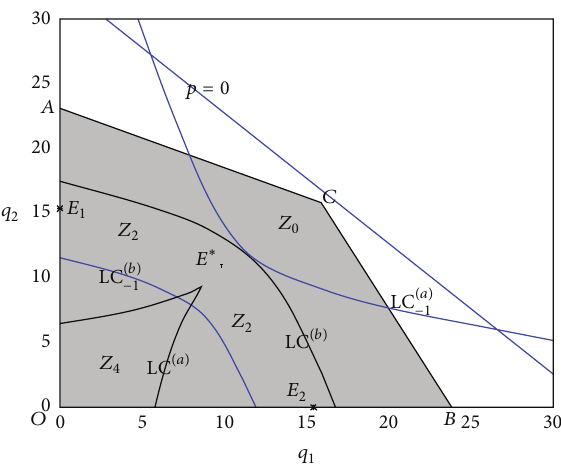
Figure 2: Critical curves are represented for the parameter set: 𝛼 = 0.3 , 𝑎 = 7.2 , 𝑏 = 0.22 , 𝑐 = 0.4 , and 𝛾 = 0.9 . The blue lines LC (𝑎) −1 and LC (𝑏) −1 are the two branches of the LC −1 set. The portion of the plane that lies between the axes and LC (𝑎) defines region 𝑍 4 ; the portion of the plane that lies between the black lines LC (𝑎) and LC (𝑏) defines region 𝑍 2 ; the portion of the plane beyond LC (𝑏) defines region 𝑍 0 . In addition, 𝑂 and its preimages define the quadrilateral 𝑂𝐴𝐵𝐶 that delimitates the (grey) region of bounded trajectories. The blue line 𝑝 = 0 represents points in which the market price equals zero. The white region below the line 𝑝 = 0 represents initial conditions with respect to which trajectories lead to the invariant axes for map 𝑀 ∗ 1